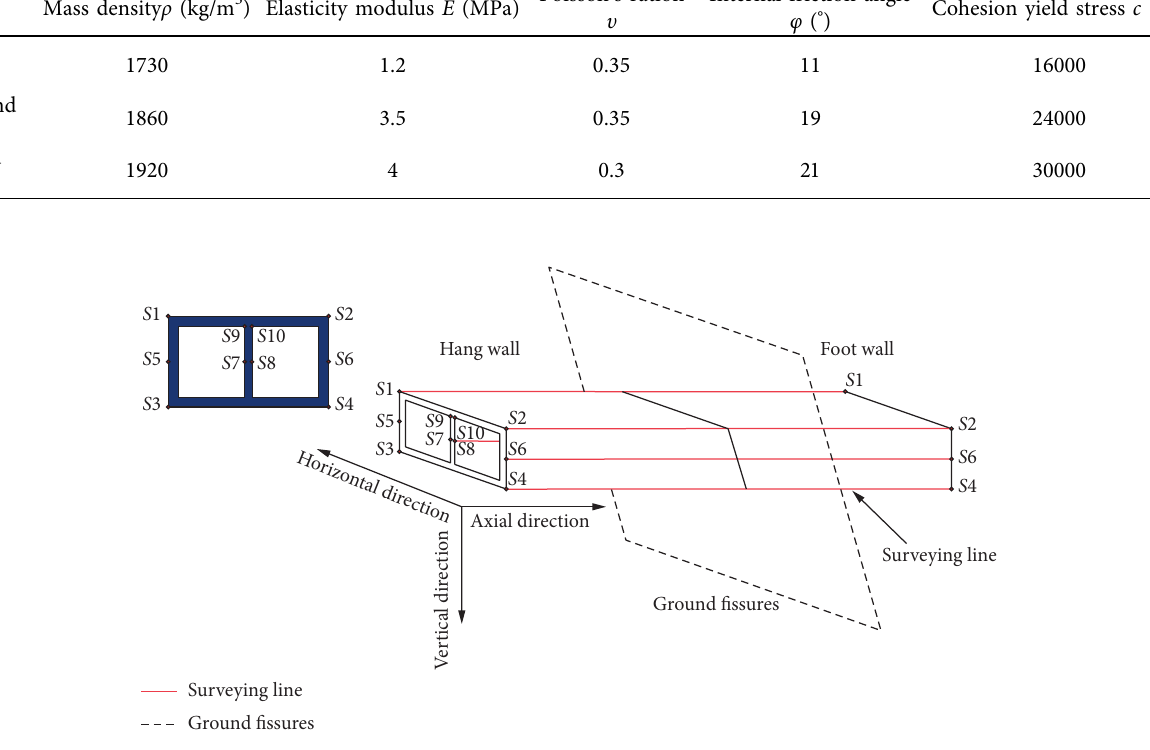
Figure 6: Surveying lines layout. S 1 � surveying line 1; S 2 � surveying line 2; S 3 � surveying line 3; S 4 � surveying line 4; S 5 � surveying line 5; S 6 � surveying line 6; S 7 � surveying line 7; S 8 � surveying line 8; S 9 � surveying line